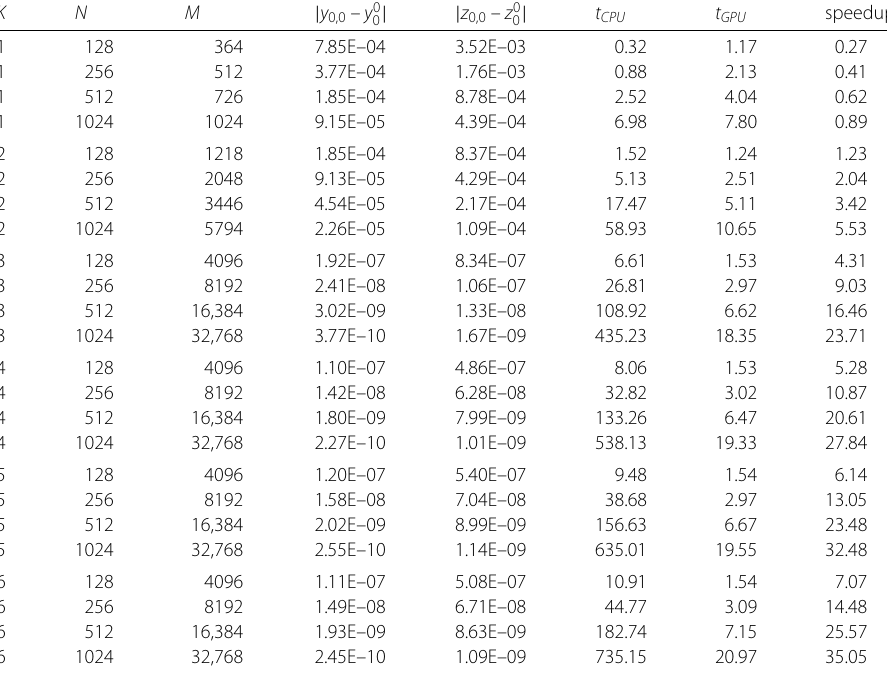
Table 5 The results for Example